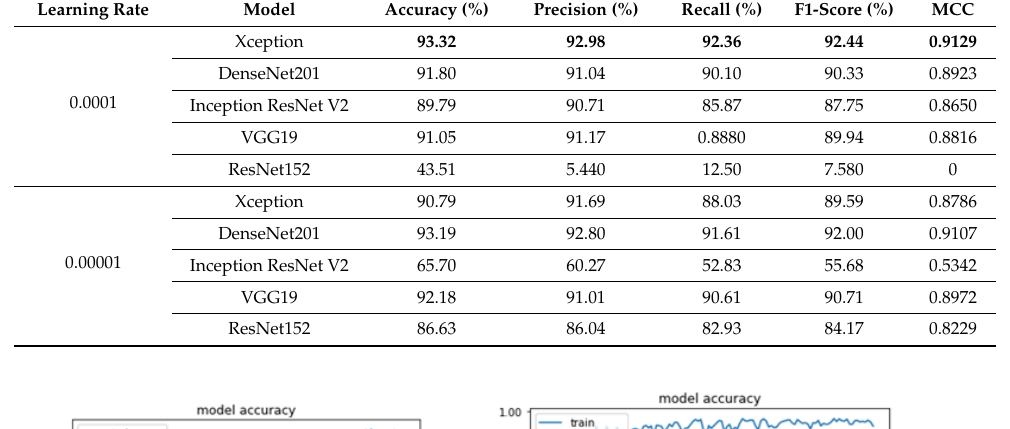
Table 9. Results of magnification-independent multi-classification; the highest results are shown in bold.